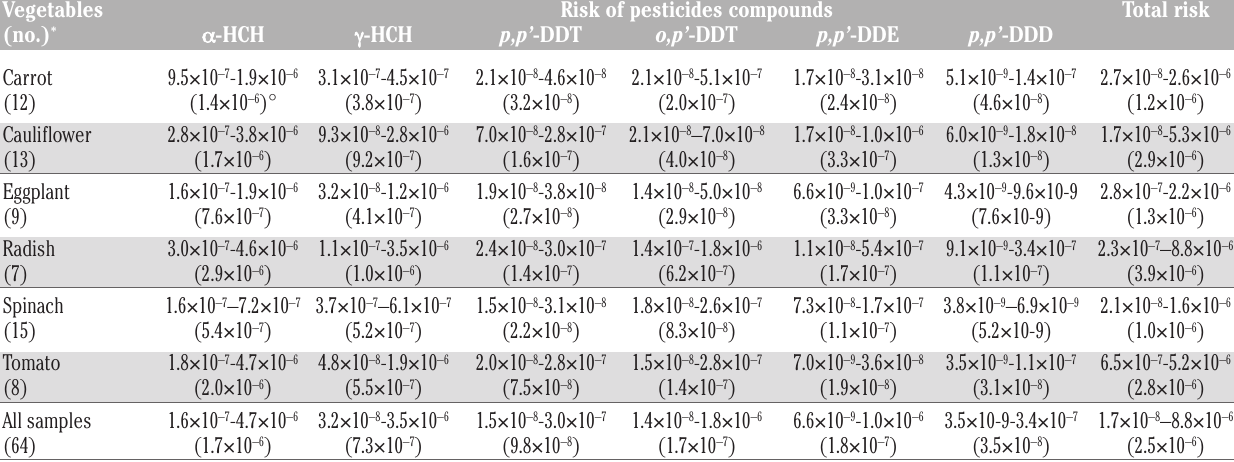
Table 3. Probable incremental life time cancer risk to humans from hexachlorocyclohexane and dichlorodiphenyltrichloroethane through vegetables. Vegetables Risk of pesticides compounds